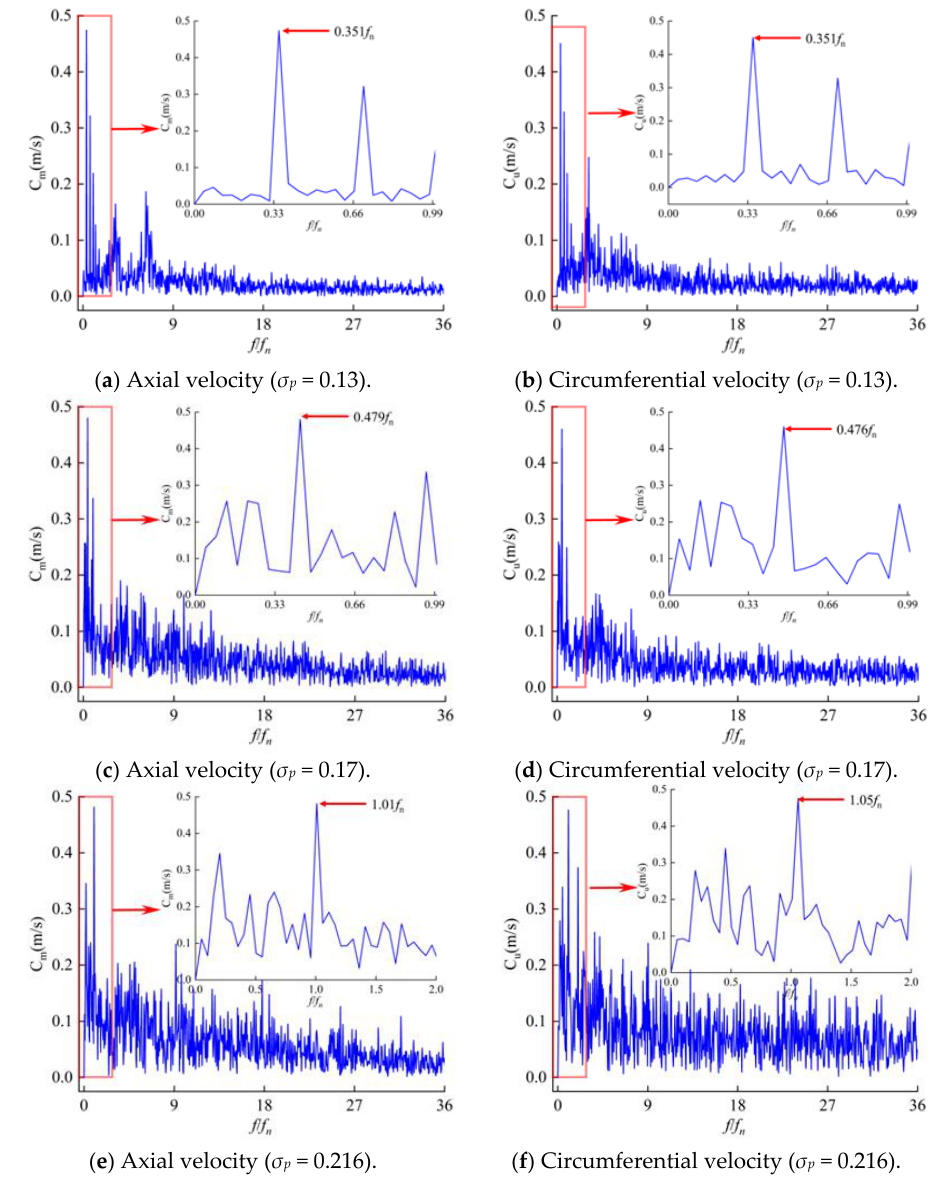
Figure 13. Draft tube velocity distribution for different cavitation coefficients under turbine mode.